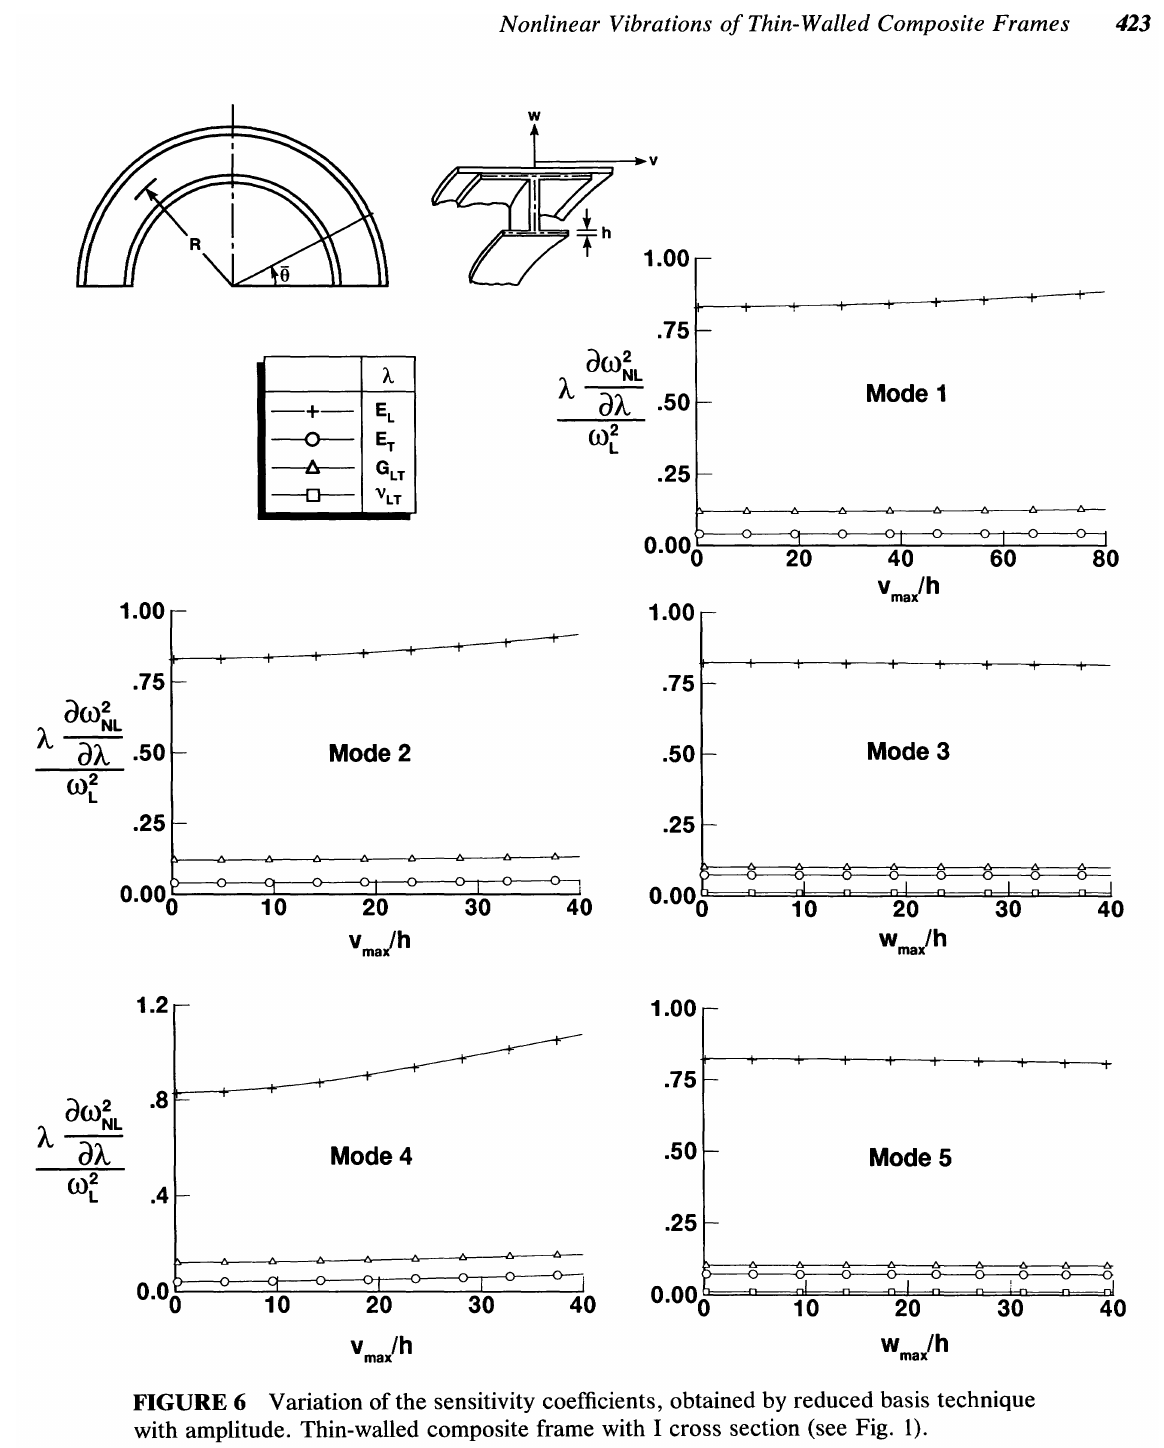
FIGURE 6 Variation ofthe sensitivity coefficients, obtained by reduced basis technique with amplitude. Thin-walled composite frame with I cross section (see Fig.